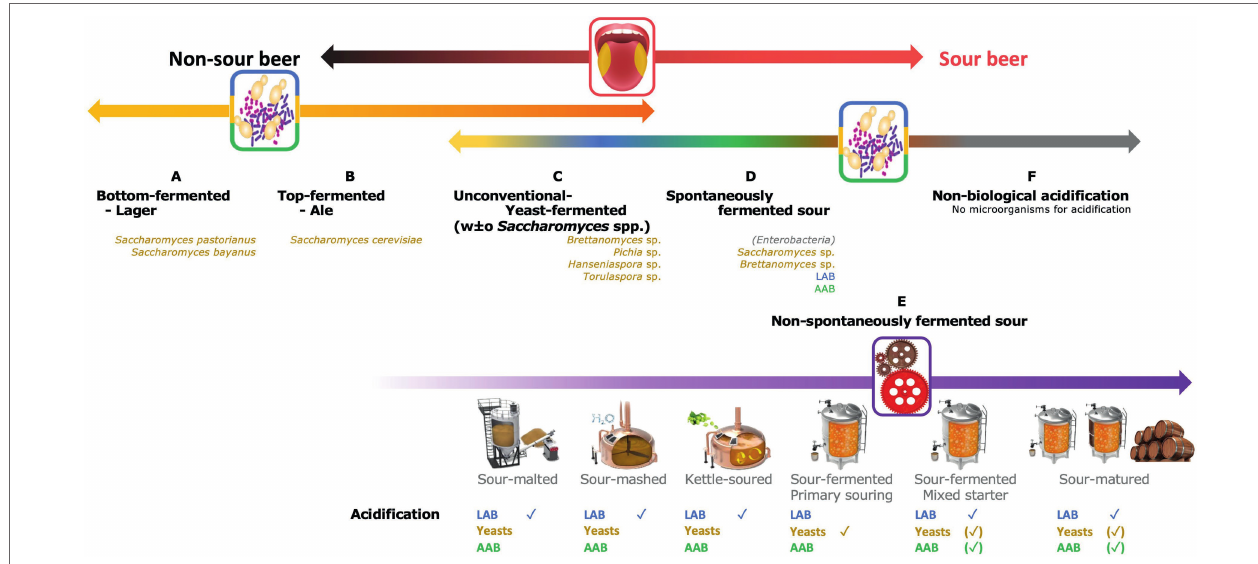
FIGURE 1 | Schematic representation of an extended beer classification. On top, a first subdivision is made based on taste [from left to right non-sour (black) to sour (red)]; in the middle, distinction is made based on the fermentation technology applied and the microorganisms involved [yeasts (yellow-orange); lactic acid bacteria (LAB, blue); acetic acid bacteria (AAB, green); and no microorganisms (gray)]. Category E is further subdivided according to the acidification technique applied and the microorganisms responsible for the acidification are